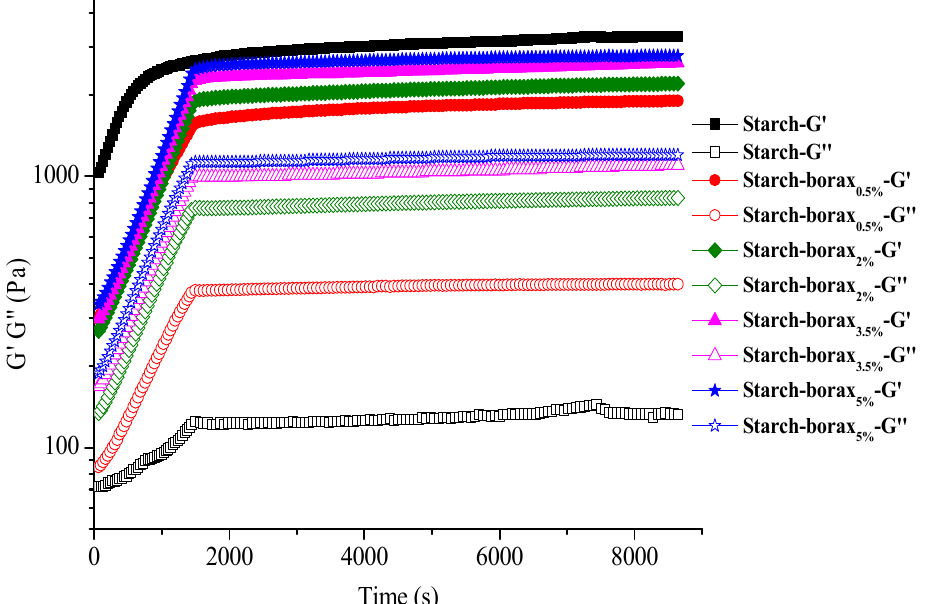
Figure 3. Time dependence of G ′ and G ″ , holding at 4 °C for starch–borax DC hydrogels with different content levels of borax, at a strain of 1%, and a frequency of 1 Hz.